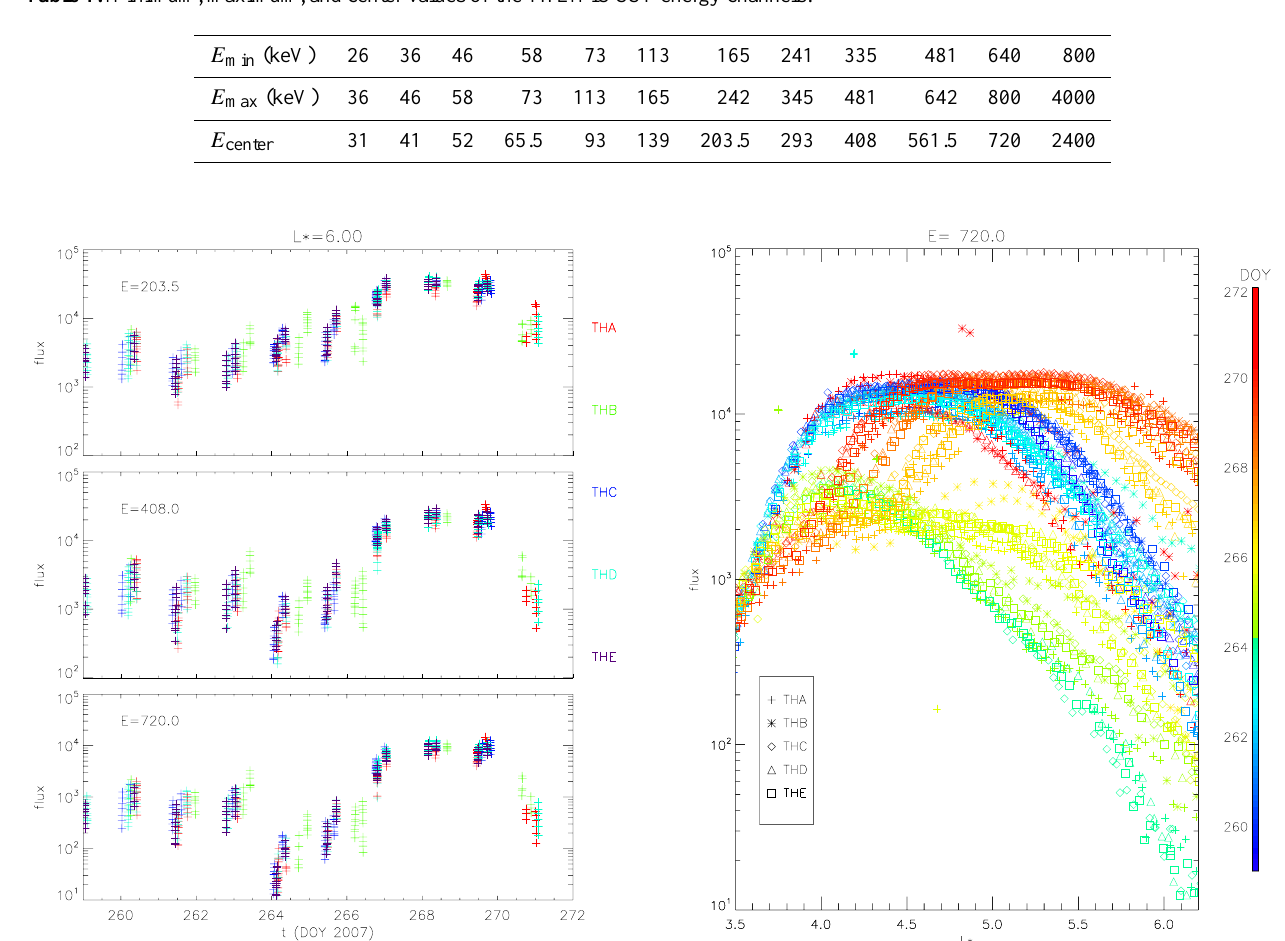
Table 1. Minimum, maximum, and center values of the THEMIS SST energy channels.